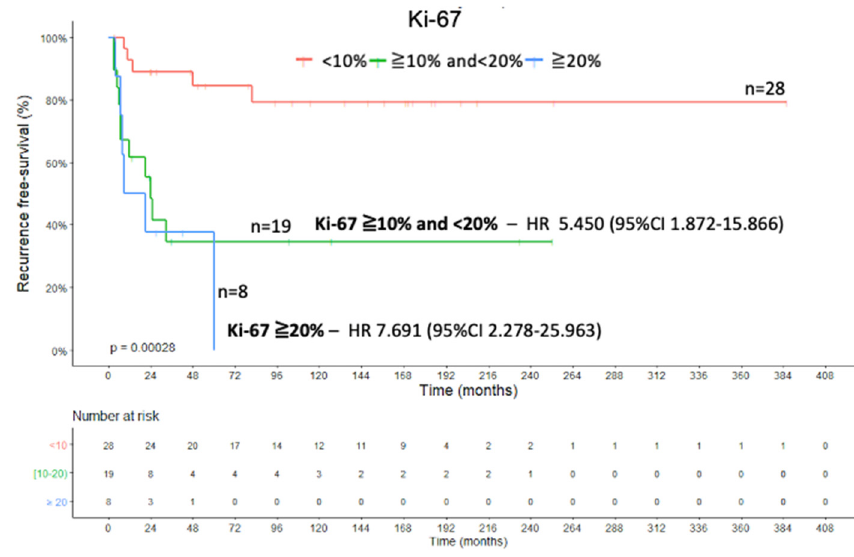
Figure 9. Ki-67 proliferation marker—Recurrence-free survival Kaplan–Meier curve.